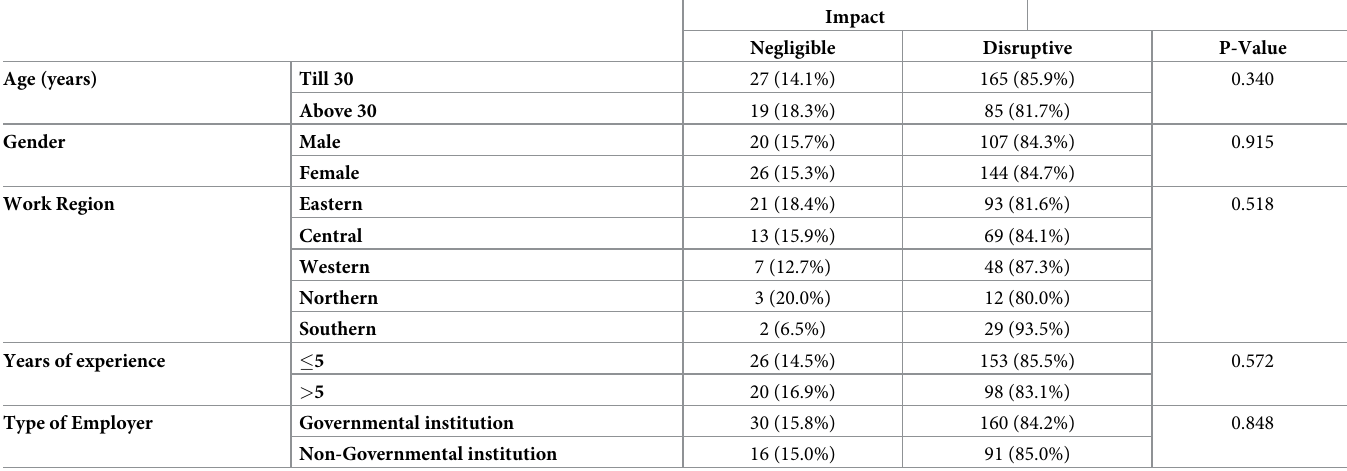
Table 1. Impact of the COVID-19 pandemic on PT practice.